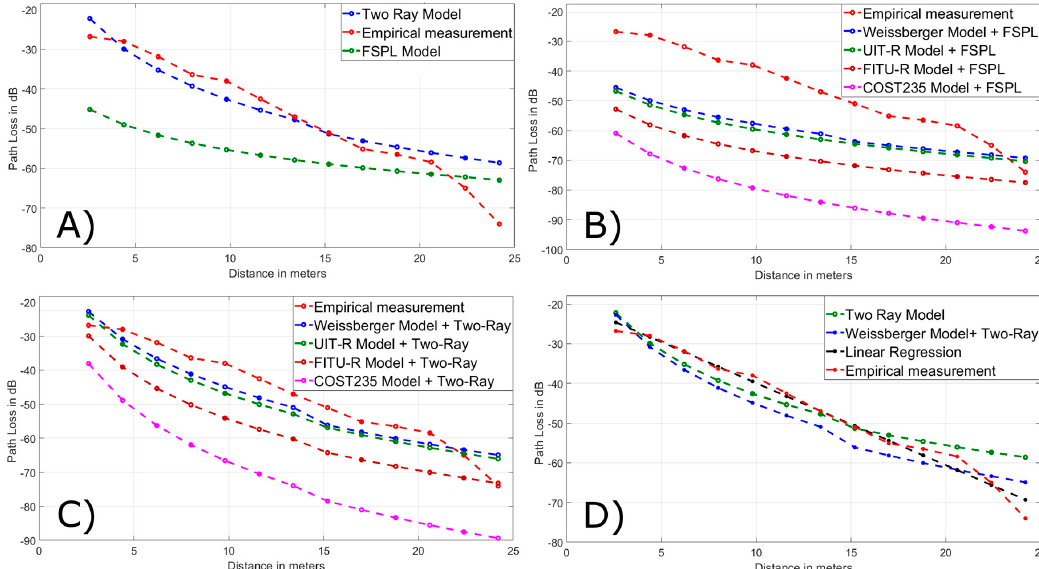
Figure 6. Field measurement at 0.5 m of soil vs. ( A ) models with line of sight (LOS), ( B ) empirical models + FSPL, ( C ) empirical models + two-ray, ( D ) optimized model (linear regression) and the others closest in values.